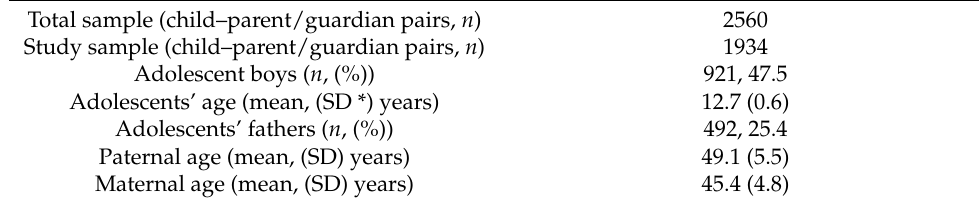
Table 1. Characteristics of the Greek GAN study sample. Total sample (child–parent/guardian pairs, n )